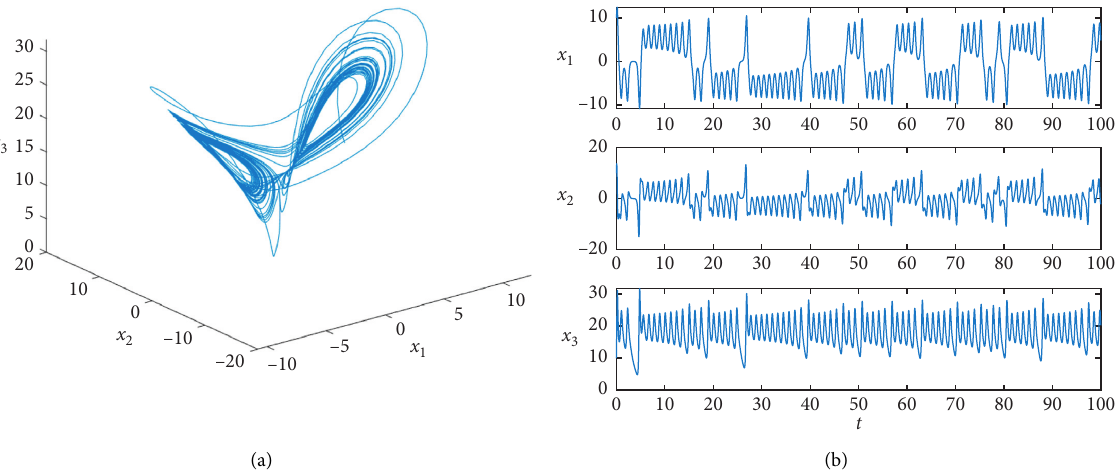
Figure 6: The chaotic phenomenon of system (27) with the initial condition X ( t i � 1, 2,